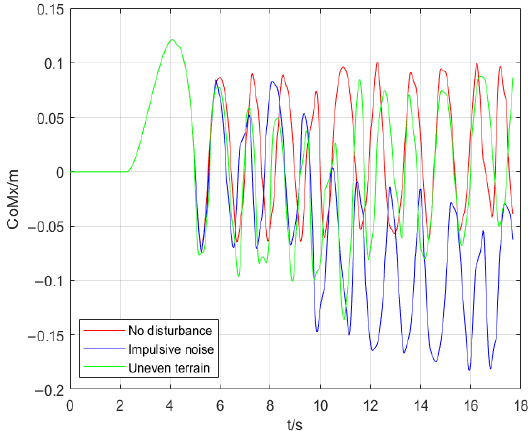
Figure 7. Displacement in the coronal plane of the CoM.